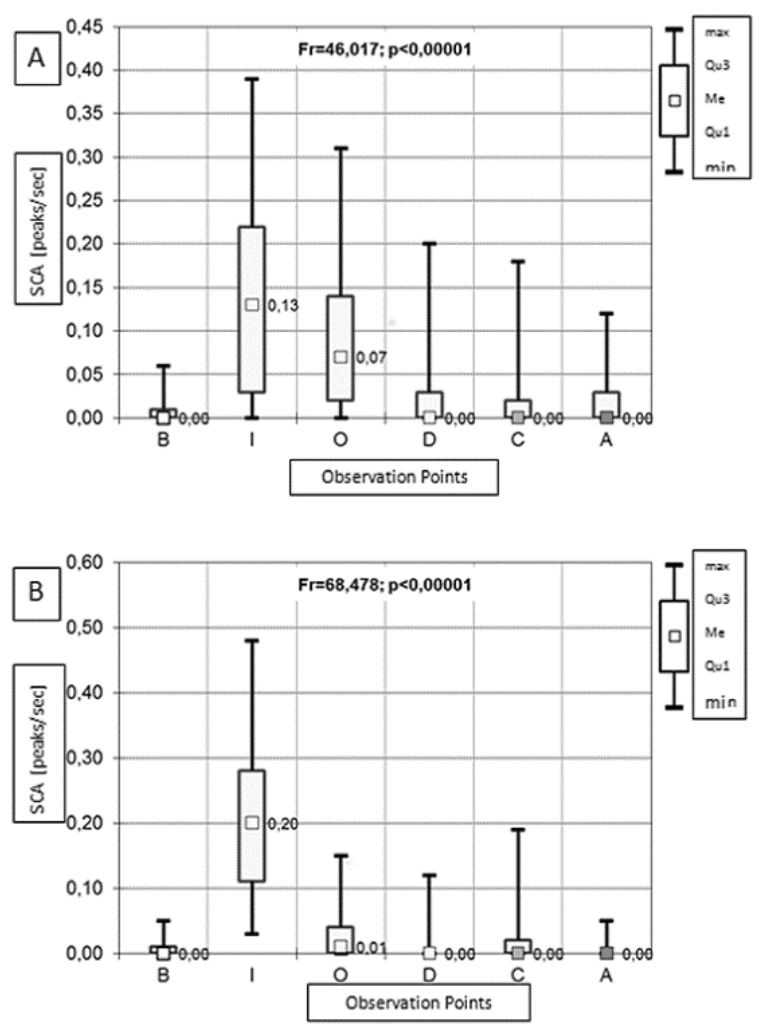
Figure 2. Variability of SCA indications (peaks · s –1 ) at the consecutive time points in the control group ( A ) and the OFA group ( B ). Data presented as the median (Me), quartile 1 (Qu1), quartile 3 (Qu3), minimum (min)m and maximum (max). SCA, skin conductance algesimeter; OFA, opioid-free anaesthesia; B, before anaesthesia induction; during: I, intubation; O, chest opening; D, pleural drainage; C, chest closing; and A, after anaesthesia. Table 5. Dunn–Bonferroni test results of SCA changes at the consecutive time points in the control and OFA groups ( p -values).